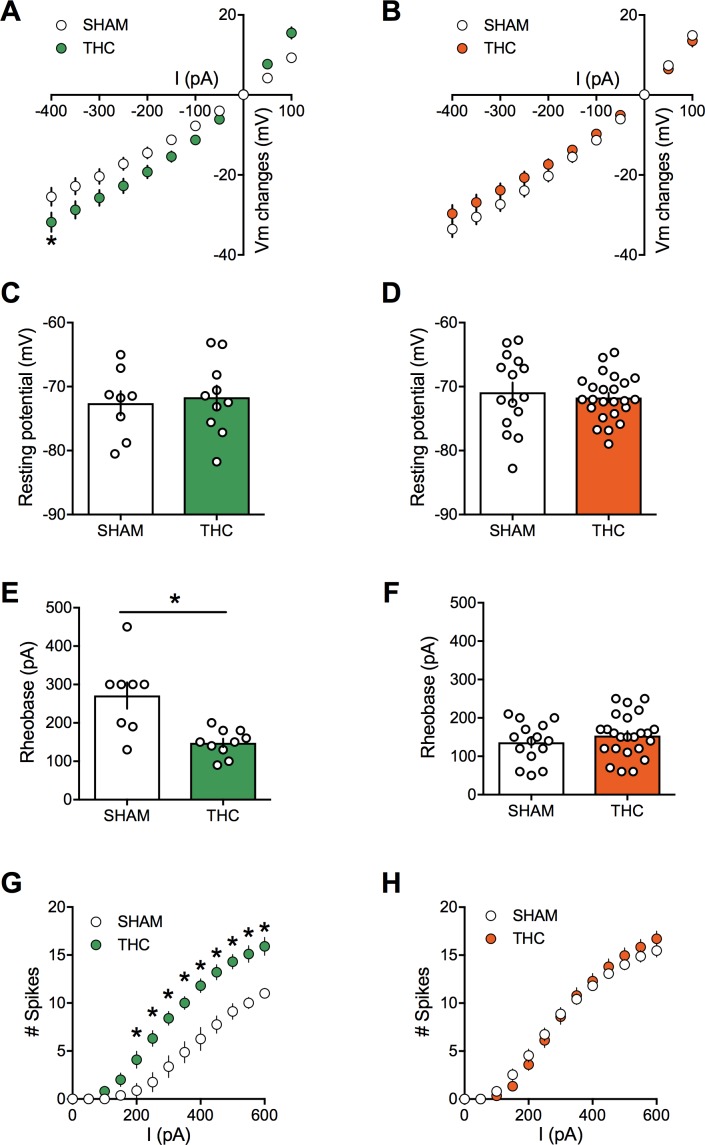
Prenatal THC exposure induces sex-specific alteration of intrinsic properties of layer five prefrontal pyramidal neurons in adult rats.(A) Current-voltage (I–V) curves recorded in SHAM (n = 8 cells/5 rats, white circles) and THC-exposed rats (n = 10 cells/5 rats, green circles) showing altered membrane potentials in male after an in utero cannabinoid exposure (F(26, 416)=1.987, p<0.05, two-way ANOVA). (B): In contrast, I-V curves were similar in SHAM group (n = 15 cells/7 rats, white circles) and THC-exposed group (n = 24 cells/7 rats, orange circles; F(26, 962)=0.534, p>0.05, two-way ANOVA). (C,D): The resting membrane potential was similar in both male (C) and female (D) rats after an in utero exposure to THC (p>0.05, Mann-Whitney U test). (E,F): The rheobase was reduced in THC-exposed male rats compared to the SHAM male (E); p<0.05, Mann-Whitney U test) whereas it was not altered in female (F); p>0.05, Mann-Whitney U test). (G): The number of evoked action potentials in response to several depolarizing current steps was higher in THC in utero treated male compared to SHAM animals (F(18, 288)=3.764, p<0.05, two-way ANOVA). (H): The number of action potential was also altered in female after an in utero treatment with THC (F(18, 666)=1.320, p<0.05, two-way ANOVA). Error bars represent SEM.